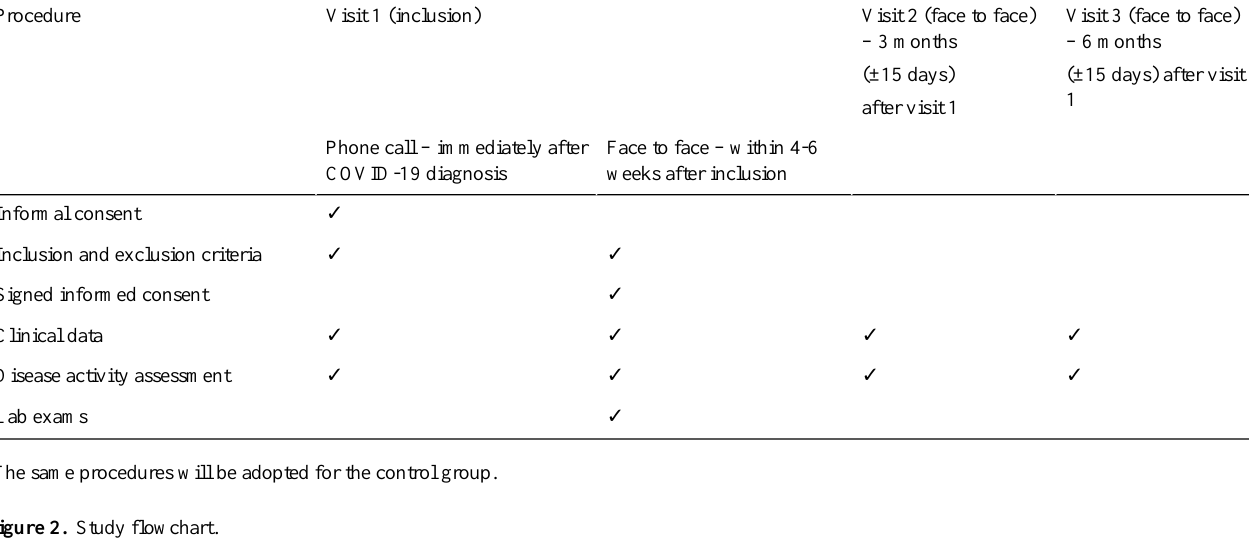
Table 1. ReumaCoV-Brasil procedures a .